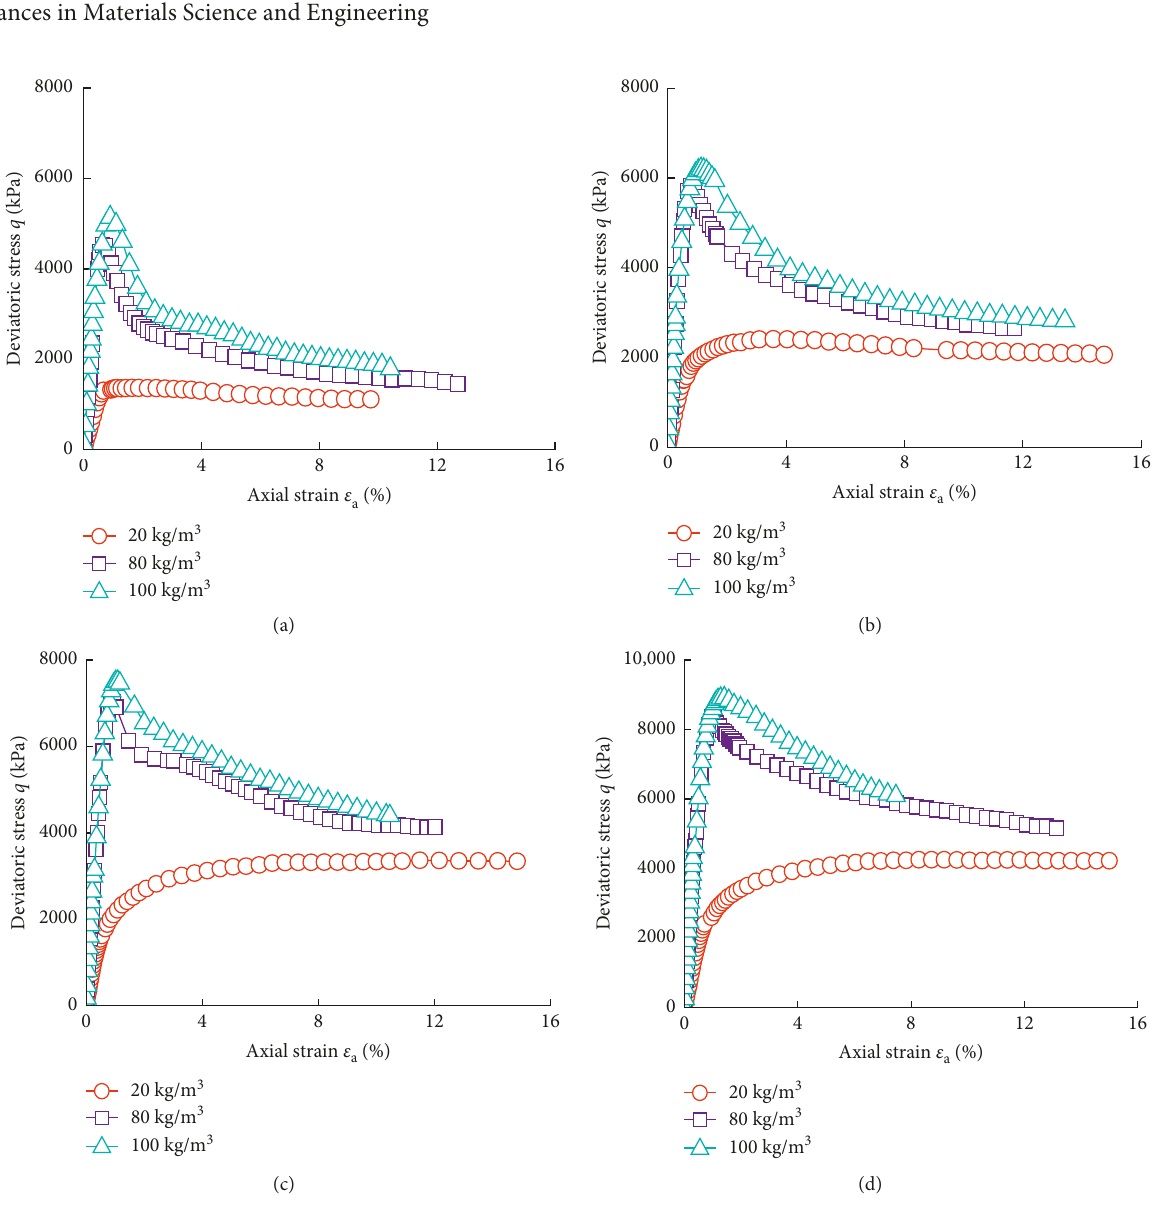
Figure 4: Stress-strain curve of Material II with regard to the effect of cementing agent content under various confining pressures: (a) 300kPa; (b) 600kPa; (c) 900kPa; (d)